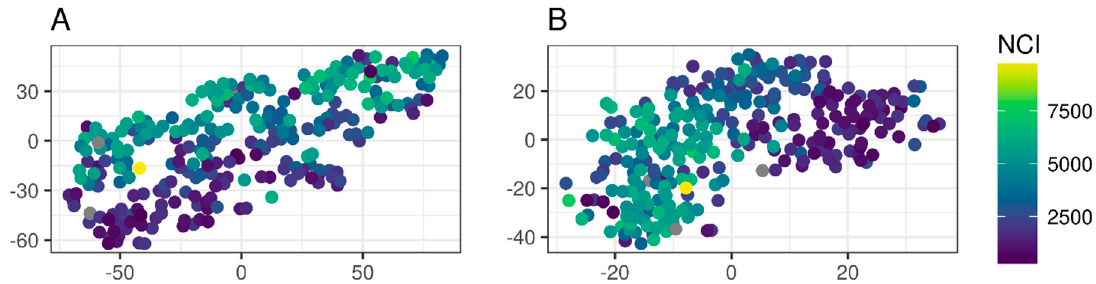
Figure 4. t-distributed Stochastic Neighbor Embedding (t-SNE) plots for ( A ) TRI patterns and ( B ) climate correlations with each point representing one tree. Points of more similar trees are plotted closer together and the neighborhood competition index (NCI) was used as color scale. Axes in t-SNE plots are dimensionless.